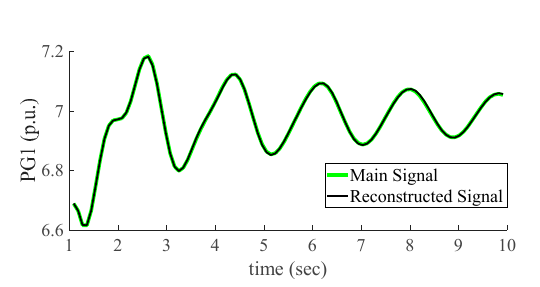
Energies 2019 , 12 , x FOR PEER REVIEW Figure 9. Comparison of main and reconstructed signals of PG1 in Test Case 2. Figure 9. Comparison of main and reconstructed signals of PG1 in Test Case 2.